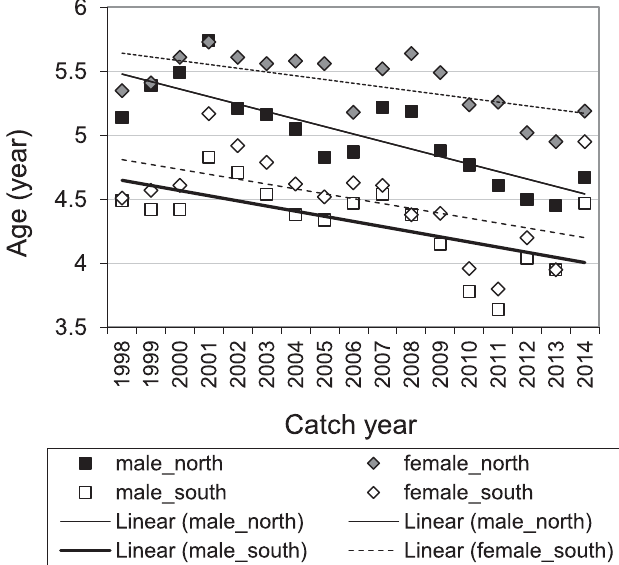
Fig. A.1. The annual mean age of anadromous male and female white fi sh ( Coregonus lavaretus ) age classes in the catch years 1998 – 2014 in the northern (north) and southern (south) Gulf of Bothnia. The mean annual age decreased over 1998 – 2014 (regression for males in north: mean age = 122.382 (cid:2) 0.058 (cid:3) year, F 1,15 =32.23, P < 0.001, r 2 = 0.661; females in north: mean age =64.824 (cid:2) 0.029 (cid:3) year, F 1,15 =11.01, P =0.005, r 2 = 0.423; males in south: mean age = 84.170 (cid:2) 0.039 (cid:3) year, F 1,15 = 10.22, P = 0.006, r 2 =0.405; and females in south: mean age= 80.801 – 0.038 (cid:3) year, F 1,15 = 5.59, P = 0.032, r 2 =0.272).